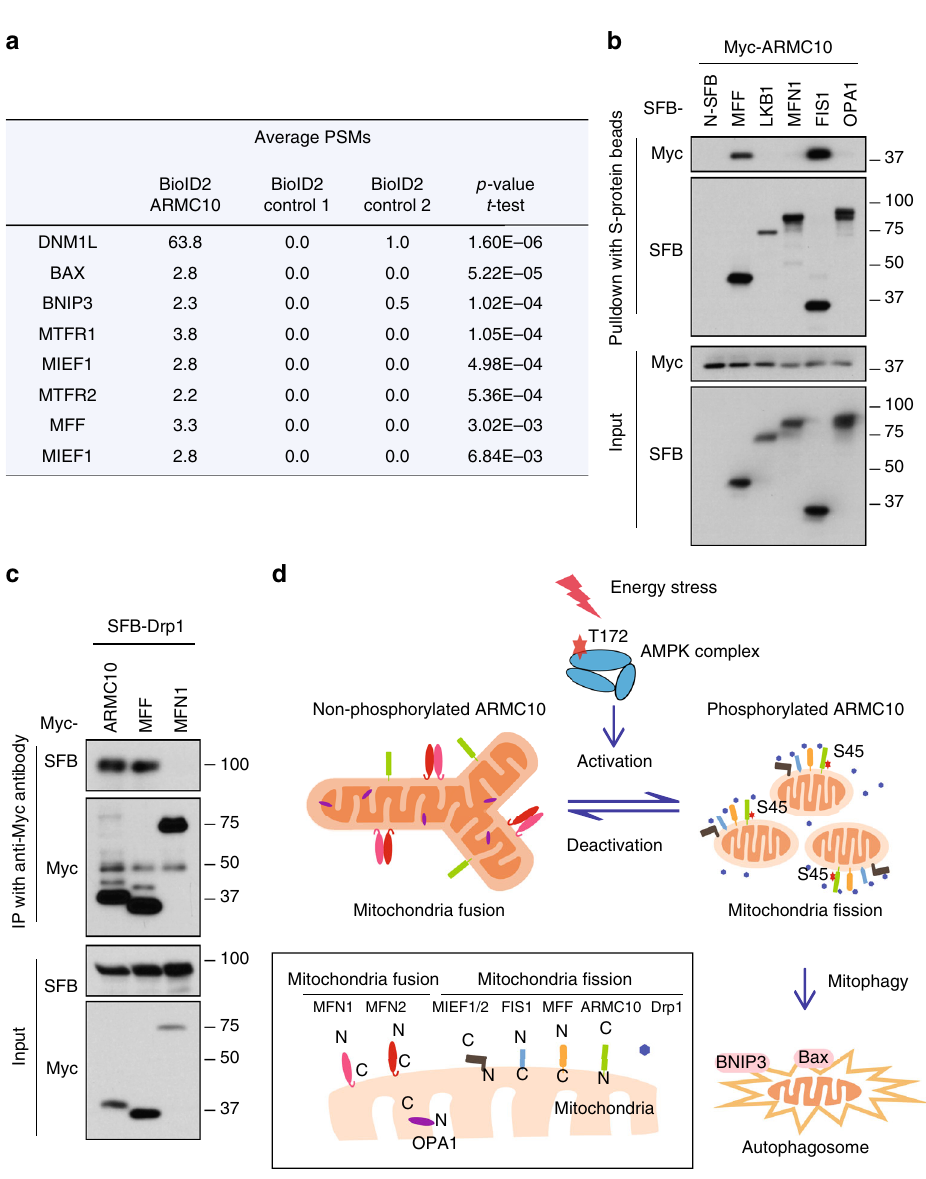
Fig. 6 ARMC10 associates with mitochondrial fi ssion proteins. a Mitochondrial fi ssion proteins enriched by BioID pulldown with the bait protein ARMC10. Six repeats with the BioID2-tagged ARMC10 and eight controls. Control 1, BioID2 tag fused with mitochondria localization sequence (two repeats); control 2, BioID2 tag fused with a nonrelated bait protein, SLX4IP (six repeats), were conducted for the BioID experiments. The peptide spectrum matches (PSM) presented are the average numbers of PSMs of the candidate interacting genes involved in mitochondrial fi ssion and/or mitophagy identi fi ed in ARMC10 or control groups. The p values represent statistical analysis of identi fi ed PSMs of the BioID2-tagged ARMC10 binding proteins comparing to those identi fi